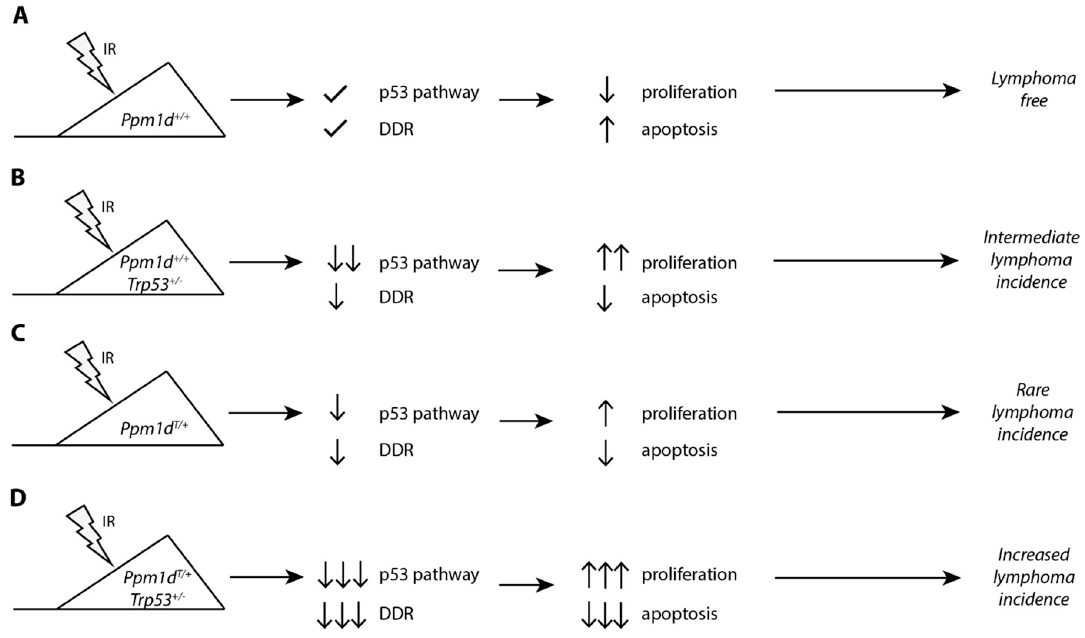
Figure 4. A proposed model for the role of truncated PPM1D in the ionizing radiation-induced lymphoma. Mice carrying wild-type Ppm1d and Tpr53 activate the p53 pathway and DNA damage response upon exposure to ionizing radiation leading to block of the cell proliferation or to apoptosis in